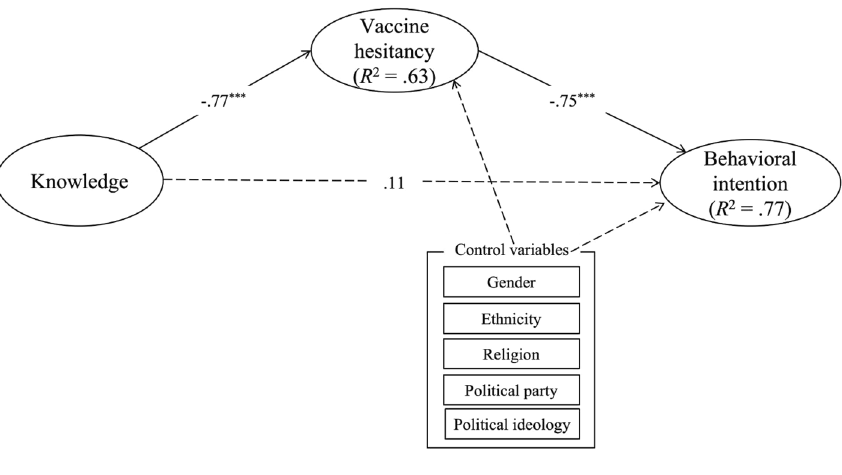
Figure 1. Results of the SEM depicting direct and indirect effects (Study 2). Estimates are indicated in standardized values and the dashed lines indicate non-significant paths. *** p <